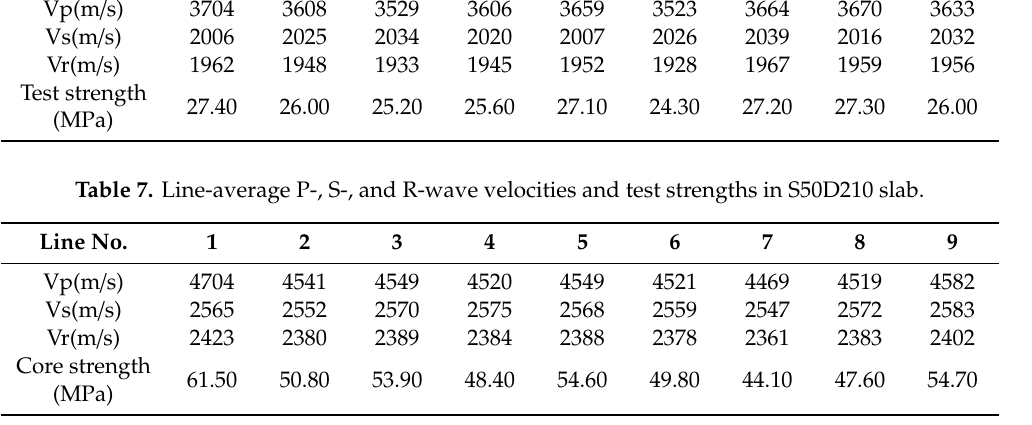
Table 6. Line-average P-, S-, and R-wave velocities and test strengths in S24D210 slab. Line No.